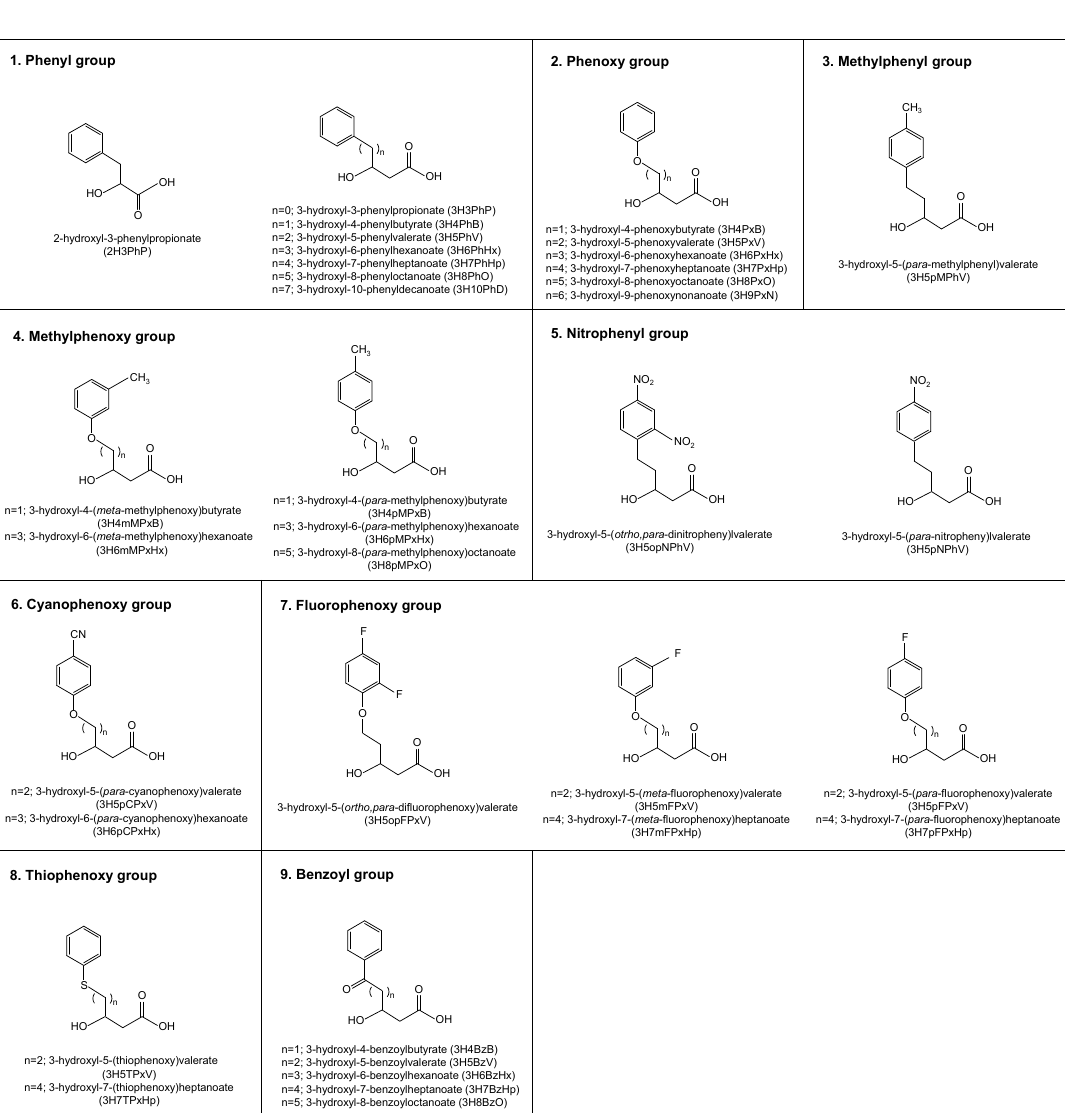
Figure 1. Structures of aromatic monomer units introduced into biosynthetic polyhydroxyalkanoates (PHAs). A monomer containing a nitrophenoxy group was also reported, but the detailed structure, including the carbon number, was not presented [24].